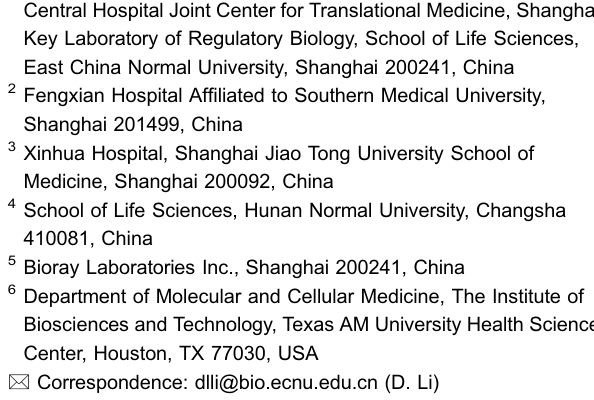
b Figure 2. Fusion of the adenosine deaminase with Cas9 variants . (A) A schematic view of SaKKH-ABE and VQR-ABE vectors. (B) Frequencies of A>G conversions induced by SaKKH-ABE in HEK293T cell line. (C) Frequencies of A>G conversions induced by VQR-ABE in HEK293T cell line. (D) Genotypes of the founders produced by the SaKKH-ABE system in the Otc locus. Target sequence is underlined. Arrow head indicates the targeted thymine. PAM sequence is labeled in blue. Base substitutions are labeled in red. Allele frequencies are listed to the right. (E) Genotypes of the founders produced by the VQR-ABE system in the Hbb-bs locus. Target sequence is underlined. Arrow head indicates the targeted thymine. PAM sequence is labeled in blue. Base substitutions are labeled in red. Allele frequencies are listed to the right. (F) Summary of the targeted sites and injection parameters used to generate the point mutant rodents in the